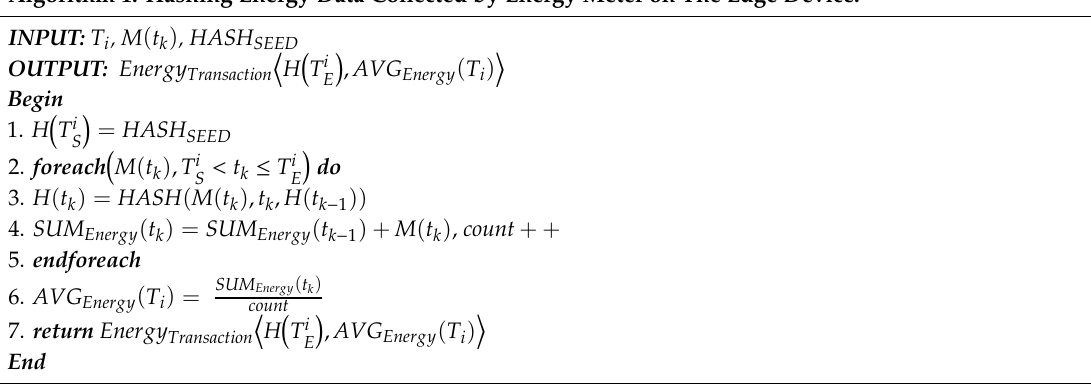
Algorithm 1: Hashing Energy Data Collected by Energy Meter on The Edge Device.